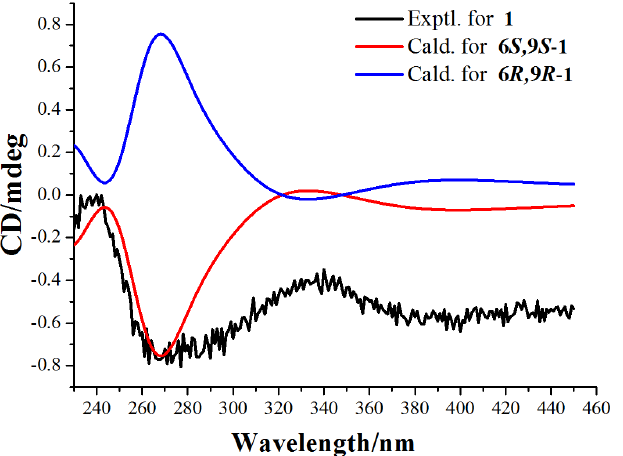
Figure 3. Experimental ECD spectra and calculated ECD spectra of compound 1 at the M06- 2X/Def2SVP level in methanol.